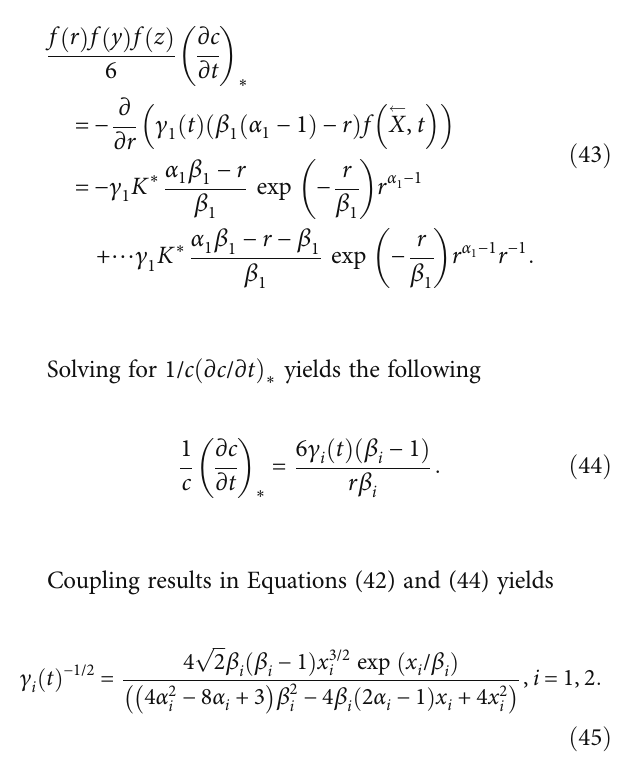
Table 5: Comparing methods of fi nding densities. Method AIC SBIC Plackett